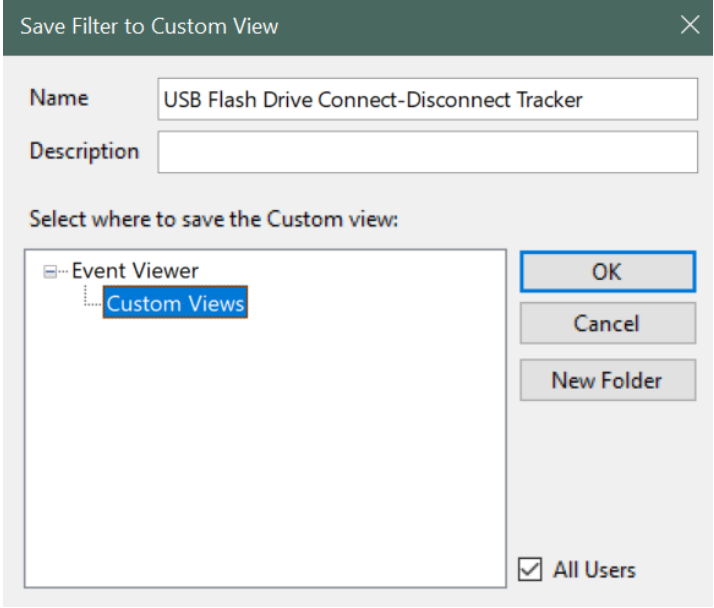
Figure 10. Naming the custom filter of Windows Event